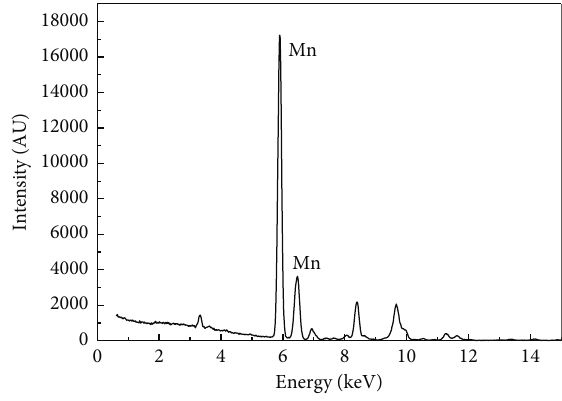
Figure 4: EDX patterns for the 2wt. % Mn/AC.